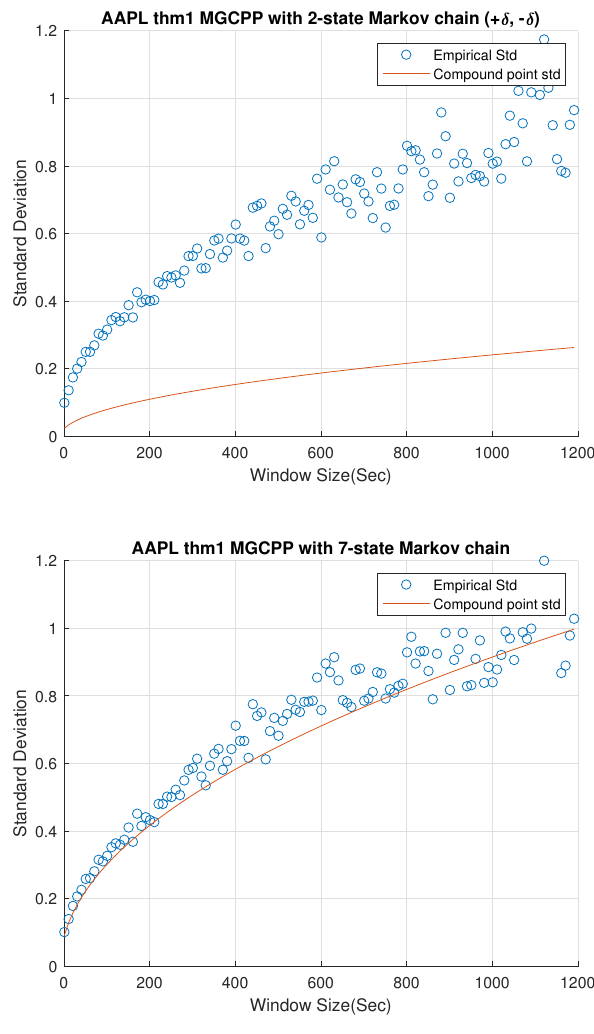
Figure 2. Standard deviation comparisons for MGCPP with 2-state Markov chain and 7-state Markov chain simulated by Apple’s stock